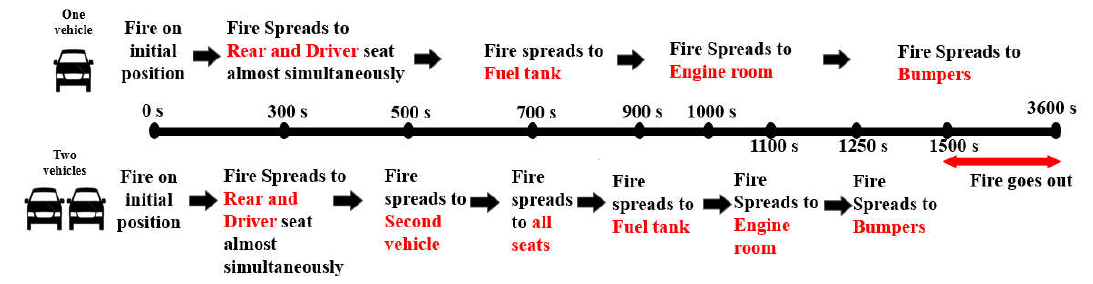
Figure 5. Fire spreading as a function of time for one and two vehicles; ( a ) 150 s after fires in one vehicle, ( b ) 300 s after fires in one vehicle, ( c ) 500 s after fires in one vehicle, ( d ) 700 s after fires in one vehicle, ( e ) 1160 s after fires in one vehicle, ( f ) 150 s after fires in two vehicles, ( g ) 300 s after fires in two vehicles, ( h ) 500 s after fires in two vehicles, ( i ) 700 s after fires in two vehicles, and ( j ) 1160 s after fires in two vehicles.